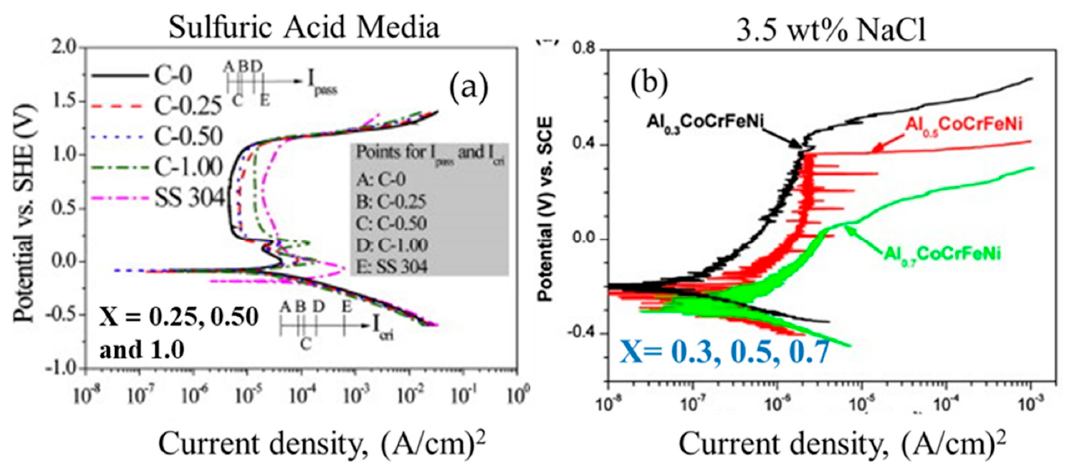
Figure 6. Potentiodynamic polarization curves of Al x CoCrFeNi alloys in ( a ) 0.5 M H 2 SO 4 solution at Al content 0, 0.25, 0.5, 1.0; as compared with SS304, test performed at 25 °C; ( b ) 3.5 wt% NaCl solution for